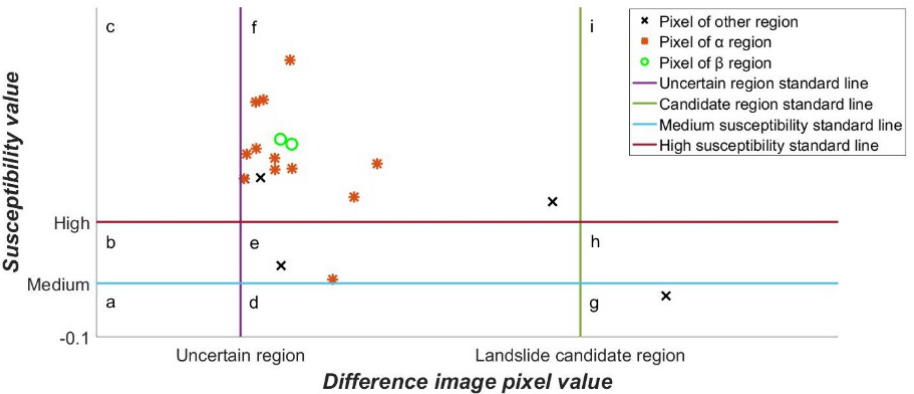
Figure 18. Scatter plot of sub-area C.